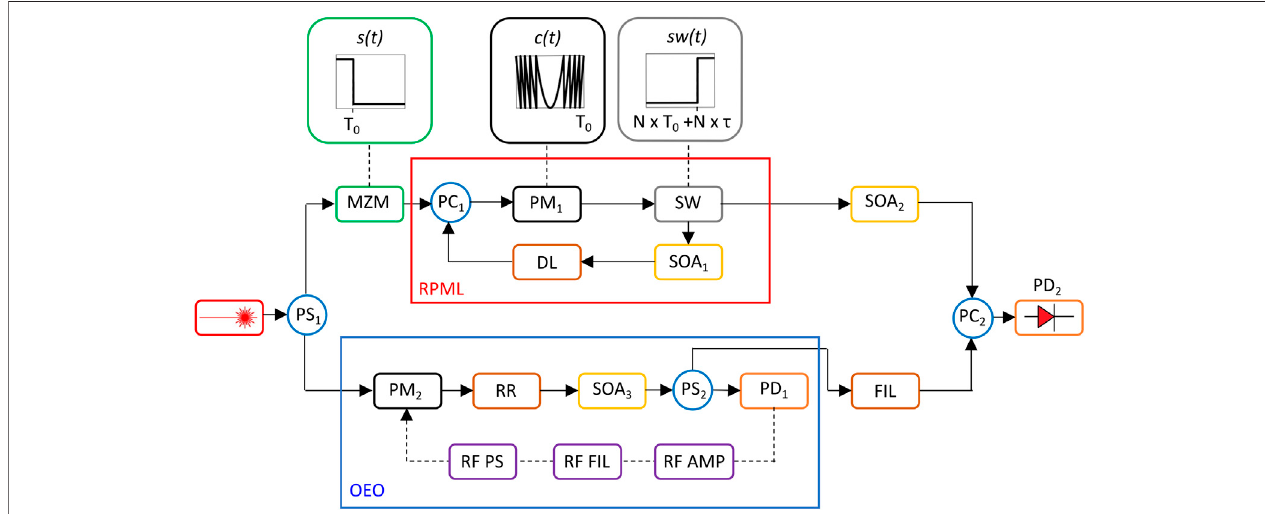
FIGURE1 | Proposed linearly chirped microwave generator (LCMW)architectureincluding the recirculating phase modulation loop(RPML) and theoptoelectronic oscillator(OEO) (PS j :power splitter ( j = 1 – 2); PM j : phase modulator( j =1 – 2); MZM: Mach – Zehnder modulator; PC j : power combiner( j =1 – 2); DL: delay line;SW: switch; RR:ringresonator;SOA i ( i =1 – 3):semiconductoropticalampli fi er;FIL:high-ER fi lter;PD j :photodiode( j =1 – 2);RFPS:RFphaseshifter;RFAMP : RFampli fi er,RFFIL : RF fi